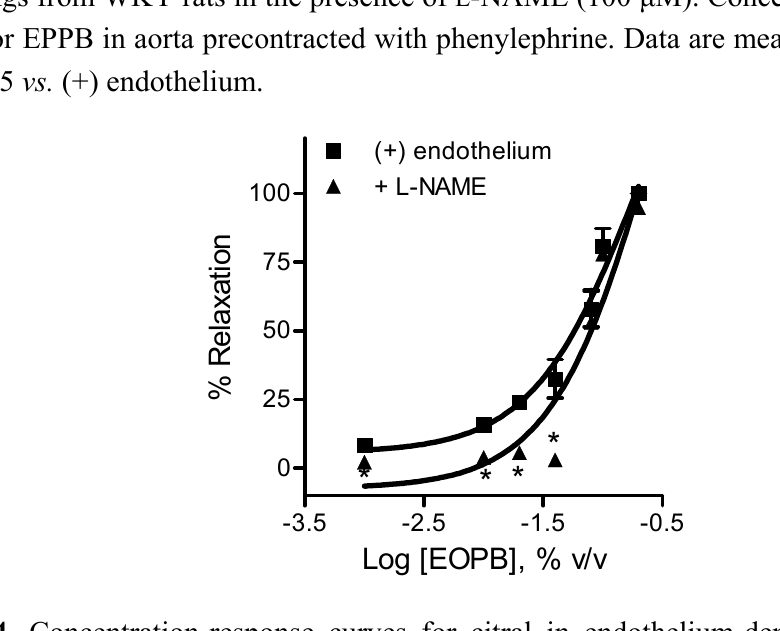
Figure 4. Concentration-response curves for citral in endothelium-denuded aorta from WKY rats, precontracted with 10 µM phenylephrine (Phe) or 80 mM KCl. Data are mean ± SEM (n = 4). * p < 0.05 vs. ( − ) endothelium